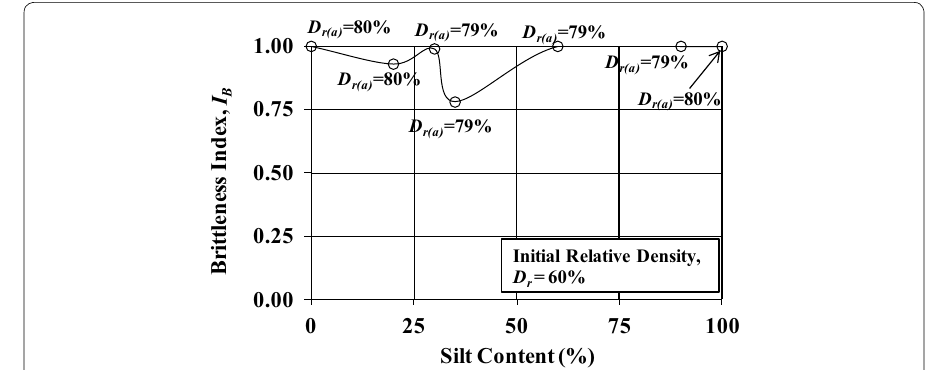
Fig. 19 Brittleness index of sand–silt mixtures at initial relative density, D r